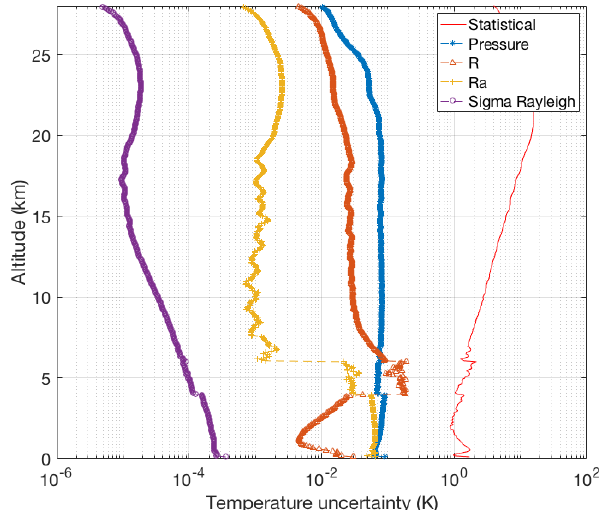
Figure 11. Same as Fig. 5 but for 10 September 2011.